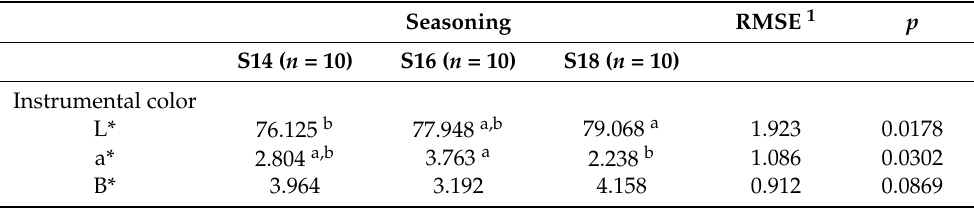
Table 1. Instrumental color of subcutaneous fat trimmed from Toscano dry-cured ham.